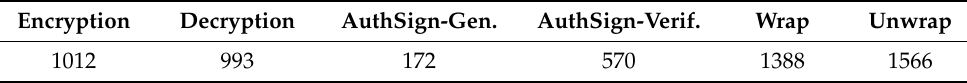
Table 2. Execution time of L2Sec functionalities on STM32L4S5VIT MCU with STSAFE-A110 enabled. Time is expressed in milliseconds